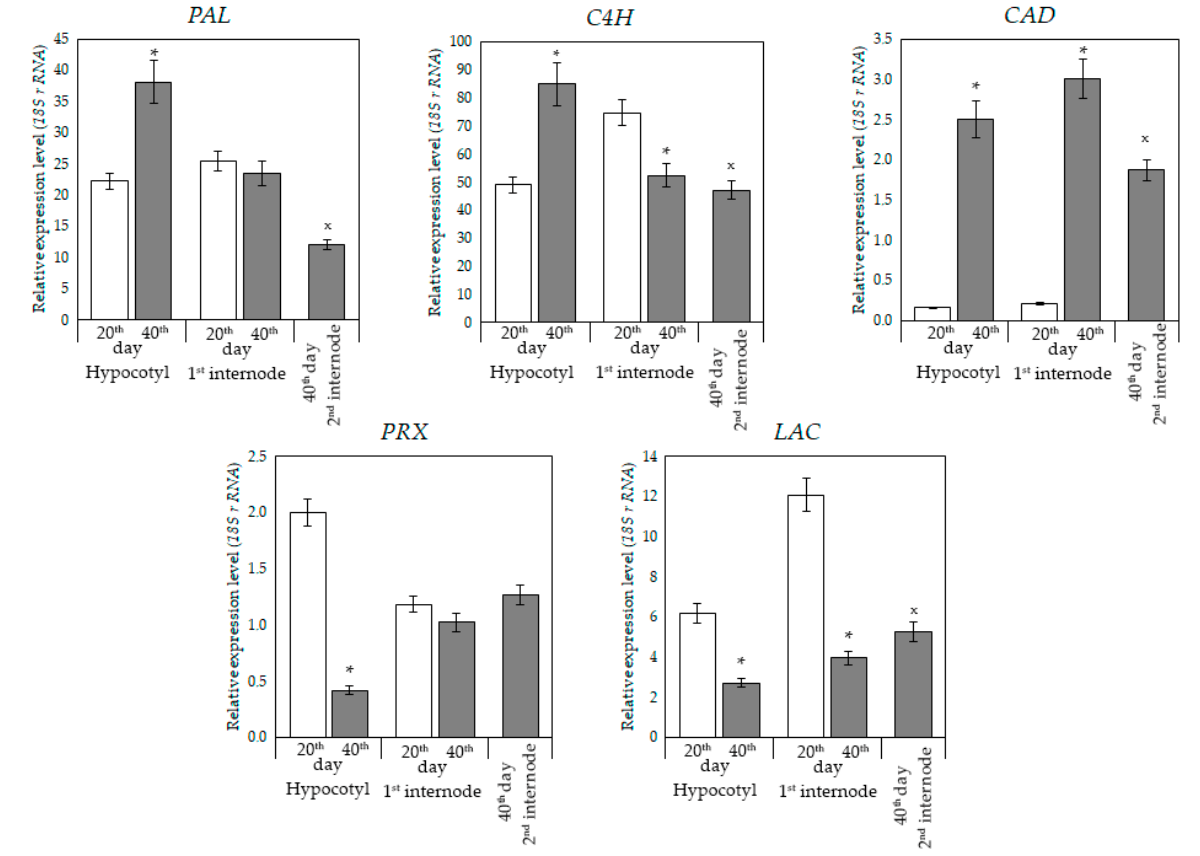
Figure 4. Relative expression level (2 − ∆∆ Ct value × 10 6 ) of phenylpropanoid biosynthesis pathway and lignin biosynthesis genes in the hypocotyl and epicotyl in zinnia on the 20th and 40th day of growth; 18S rRNA gene was used as the reference gene. Result is presented as mean ± standard error ( n = 9). Asterisks represent significant differences ( p < 0.05, U-test) for 20th and 40th days. x represents significant differences ( p < 0.05, U-test) between second and first internode on the 20th day of